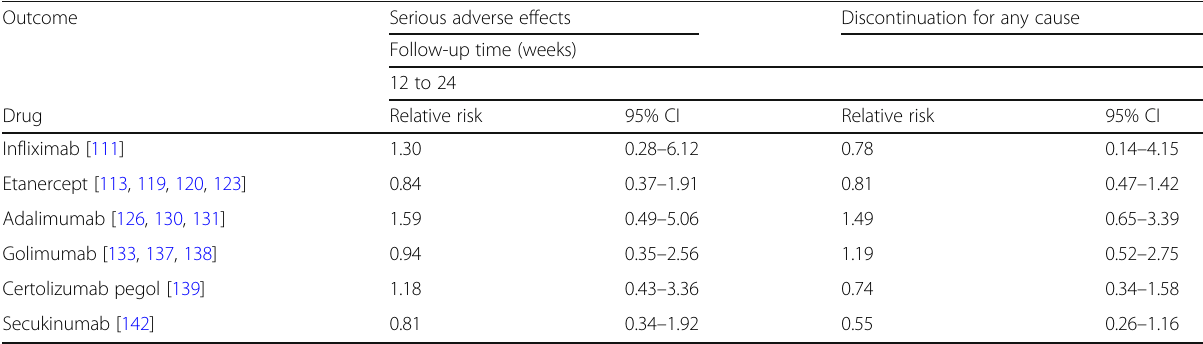
Table 4 Relative risks of different safety outcomes and respective 95% CIs calculated using a normal approximation. Data from different studies were pooled when the same outcomes from the same treatments were available and when they referred to doses and/or regimens approved in Brazil